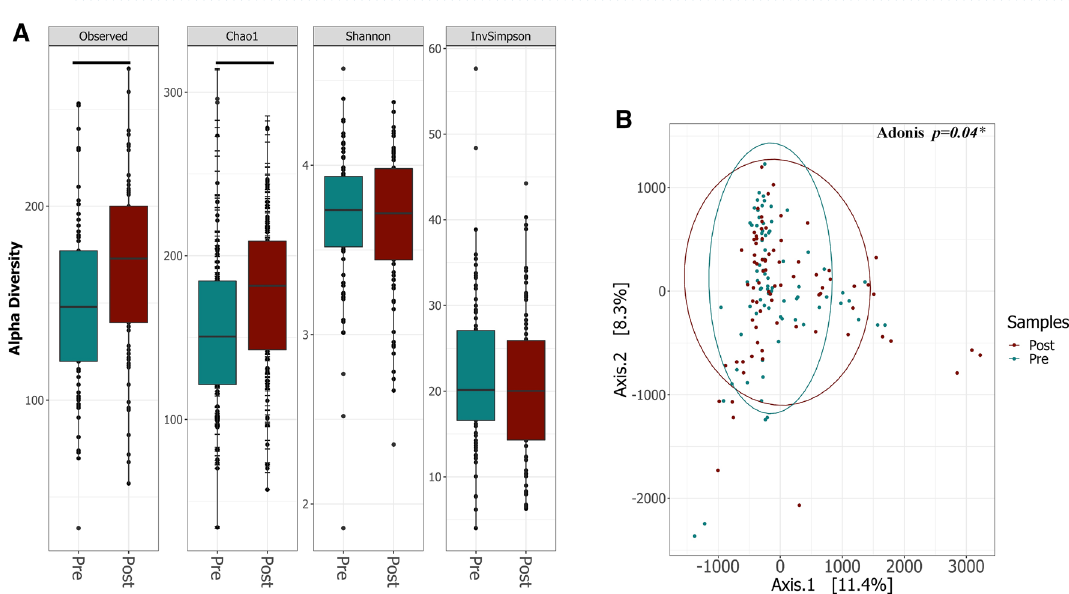
Figure 3. Diversity of microbiota composition in stool samples pre- and post- vitamin D supplementation. ( A ) Boxplots of Alpha-diversity indices: Observed OTUs; Chao1; Shannon and Inverse Simpson. Boxes represent the interquartile range (IQR) between the first and third quartiles (25th and 75th percentiles, respectively), and the horizontal line inside the box defines the median. Whiskers represent the lowest and highest values within 1.5 times the IQR from the first and third quartiles, respectively. Statistical significance was identified by the Wilcoxon test with false discovery rate (FDR)-Bonferroni corrected pairwise P values. * P < 0.05; ** P < 0.01; *** P < 0.001 and **** P < 0.0001. ( B ) PCA on a weighted UniFrac dissimilarity matrix shows significant differences in β diversity of bacterial populations pre- and post- vitamin D supplementation, with higher variance post supplementation. * P < 0.05) The figure was generated using (RStudio v 1.2 with R v 3.6) 87